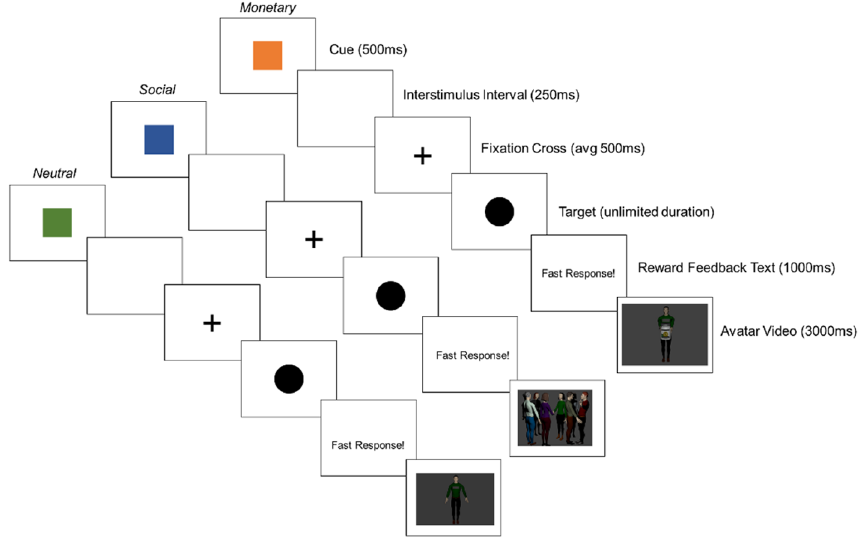
Figure 1. Monetary and social incentive delay